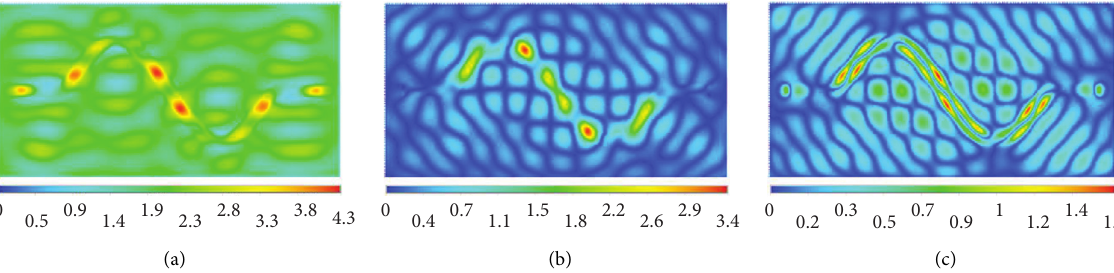
Figure 17: SV wave incident ( f � 2.0Hz, H � 100m, C